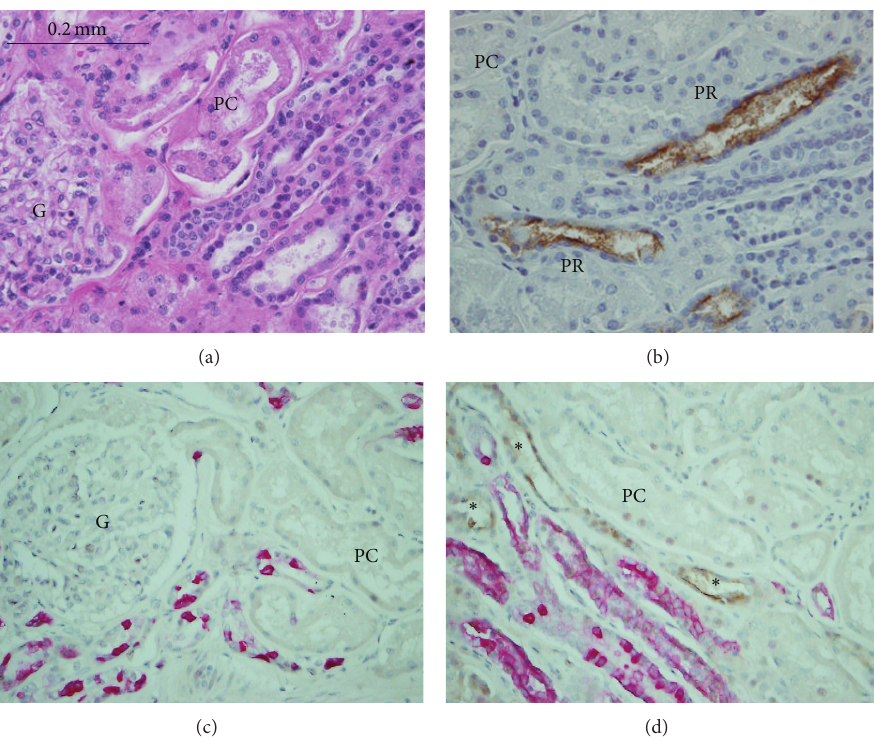
Figure 1: Acute tacrolimus nephrotoxicity, identified by KIM-1 staining in the case. On routine light microscopy, the renal tissue appears normal in pars convoluta (PC) and medullary rays located in the right lower corner of A (H&E staining). However, KIM-1 staining (B) revealed 2+ positive staining (brown color) reflective of acute kidney injury in the proximal tubules located in medullary rays (pars recta, PR) but not in the proximal tubules around glomeruli (PC), indicating acute tubular injury, a pattern consistent with acute nephrotoxicity of tacrolimus. KIM-1 and cytokeratin-7 (a distal tubular marker) coexpression is shown in C and D. In both panel C and panel D, pink stained tubules were distal nephron tubules. In panel C, PC around glomerulus stained negatively for KIM-1 and in panel D, PR in medullary rays stained positively for KIM-1 (brown color staining, indicated by asterisk). Magnification × 400 for A-B and × 200 for